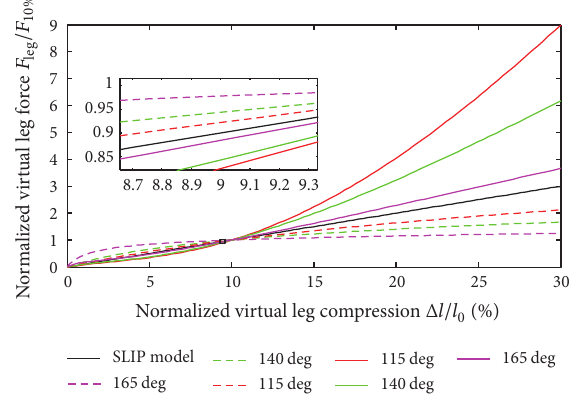
Figure 4: Normalized force-compression relationships of the SLIP model and the two-segment leg model. Solid curves are the pro- posed model and dashed ones denote the two-segment leg model with constant spring stiffness. The same nominal joint angle 𝛽 0 is adopted to facilitate the comparison of normalized force-length relationships between the two-segment leg model with “J”-curve spring stiffness and with constant spring stiffness, with the fact that red, green, and purple curves represent 𝛽 0 = 115 ∘ , 𝛽 0 = 140 ∘ , and = 165 ∘ , 𝛽 0